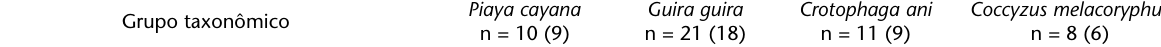
Tabela I. Composição das presas ingeridas por quatro cuculídeos resultante do exame de 42 estômagos de espécimes procedentes do sul do Brasil. Especialistas consultados: (1) Gervásio S. Carvalho, (2) Maurício M. Zenker, (3) Élio Corseuil, (4) Maria K.M. da Costa,